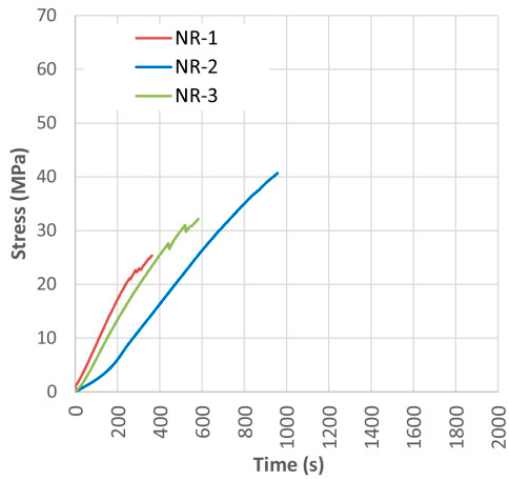
Figure 5. Bending stress over time for non-reinforced beams (NR).